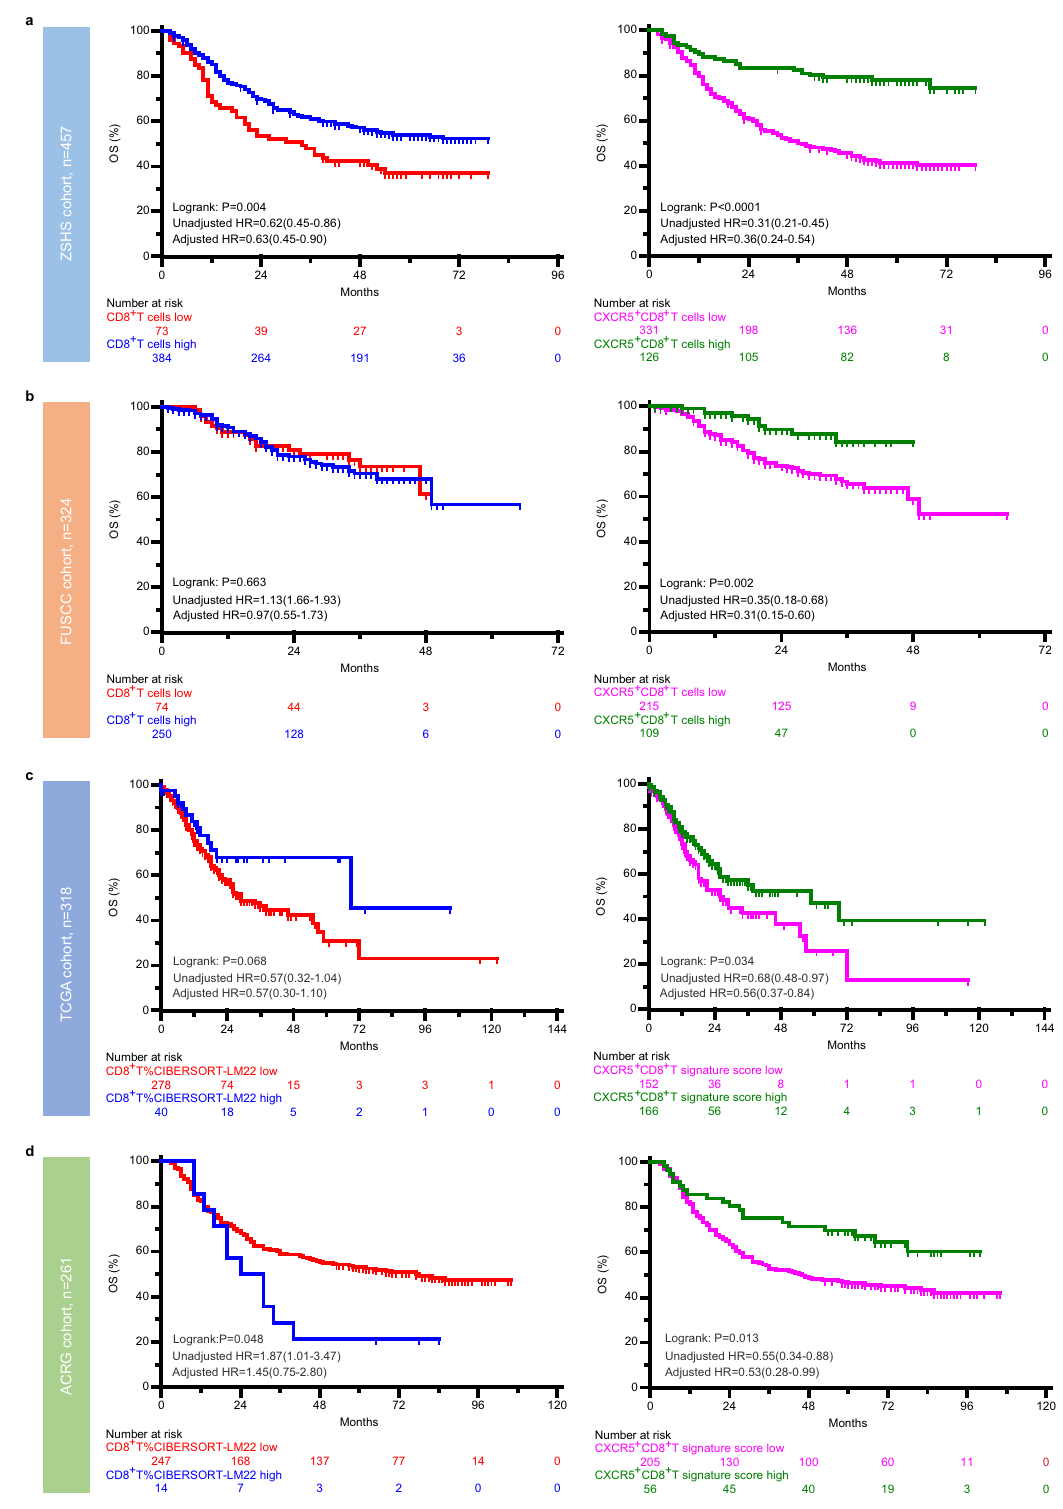
Fig. 2 Intratumoral CXCR5 + CD8 + T is associated with better OS. a – d Survival curves for CD8 + T/CXCR5 + CD8 + T cell in fi ltration (high and low) for OS in the a ZSHS, b FUSCC, c TCGA, and d ACRG cohorts. P value shown resulted from the comparison between CD8 + T/CXCR5 + CD8 + T cell low and high groups of n = 457 (ZSHS cohort), n = 324 (FUSCC cohort), n = 318 (TCGA cohort), and n = 261 (ACRG cohort) patients with gastric cancer, using the Kaplan – Meier method followed by log-rank statistical test; the unadjusted and adjusted HRs and 95% CIs are reported. Source data are provided as